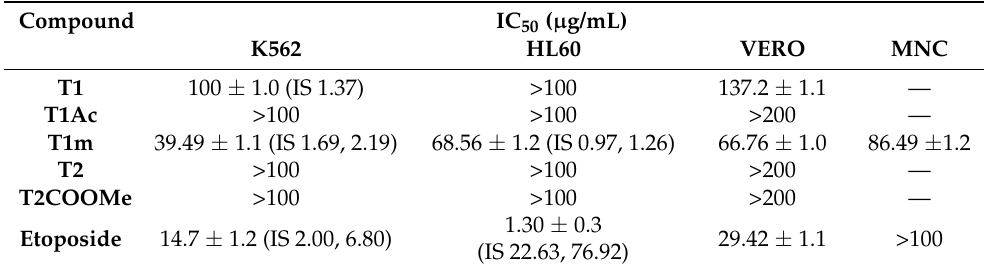
Table 1. Mean inhibitory concentrations of the lupane skeleton triterpenes were evaluated against the K562, HL60, VERO, and MNC cell